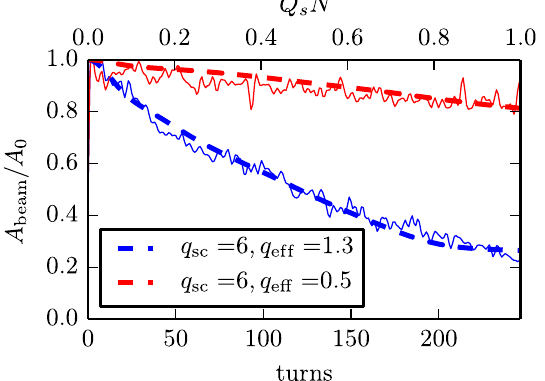
FIG. 18. Decoherence with space charge from measurements in SIS18: the solid blue line for the natural chromaticity ( ξ 1 . 3 ), the solid red line for the compensated chromaticity q eff ¼ ≈ 0 , q 0 . 5 ). The dashed lines are from simulations with ( ξ x eff ¼ the fitted q . sc